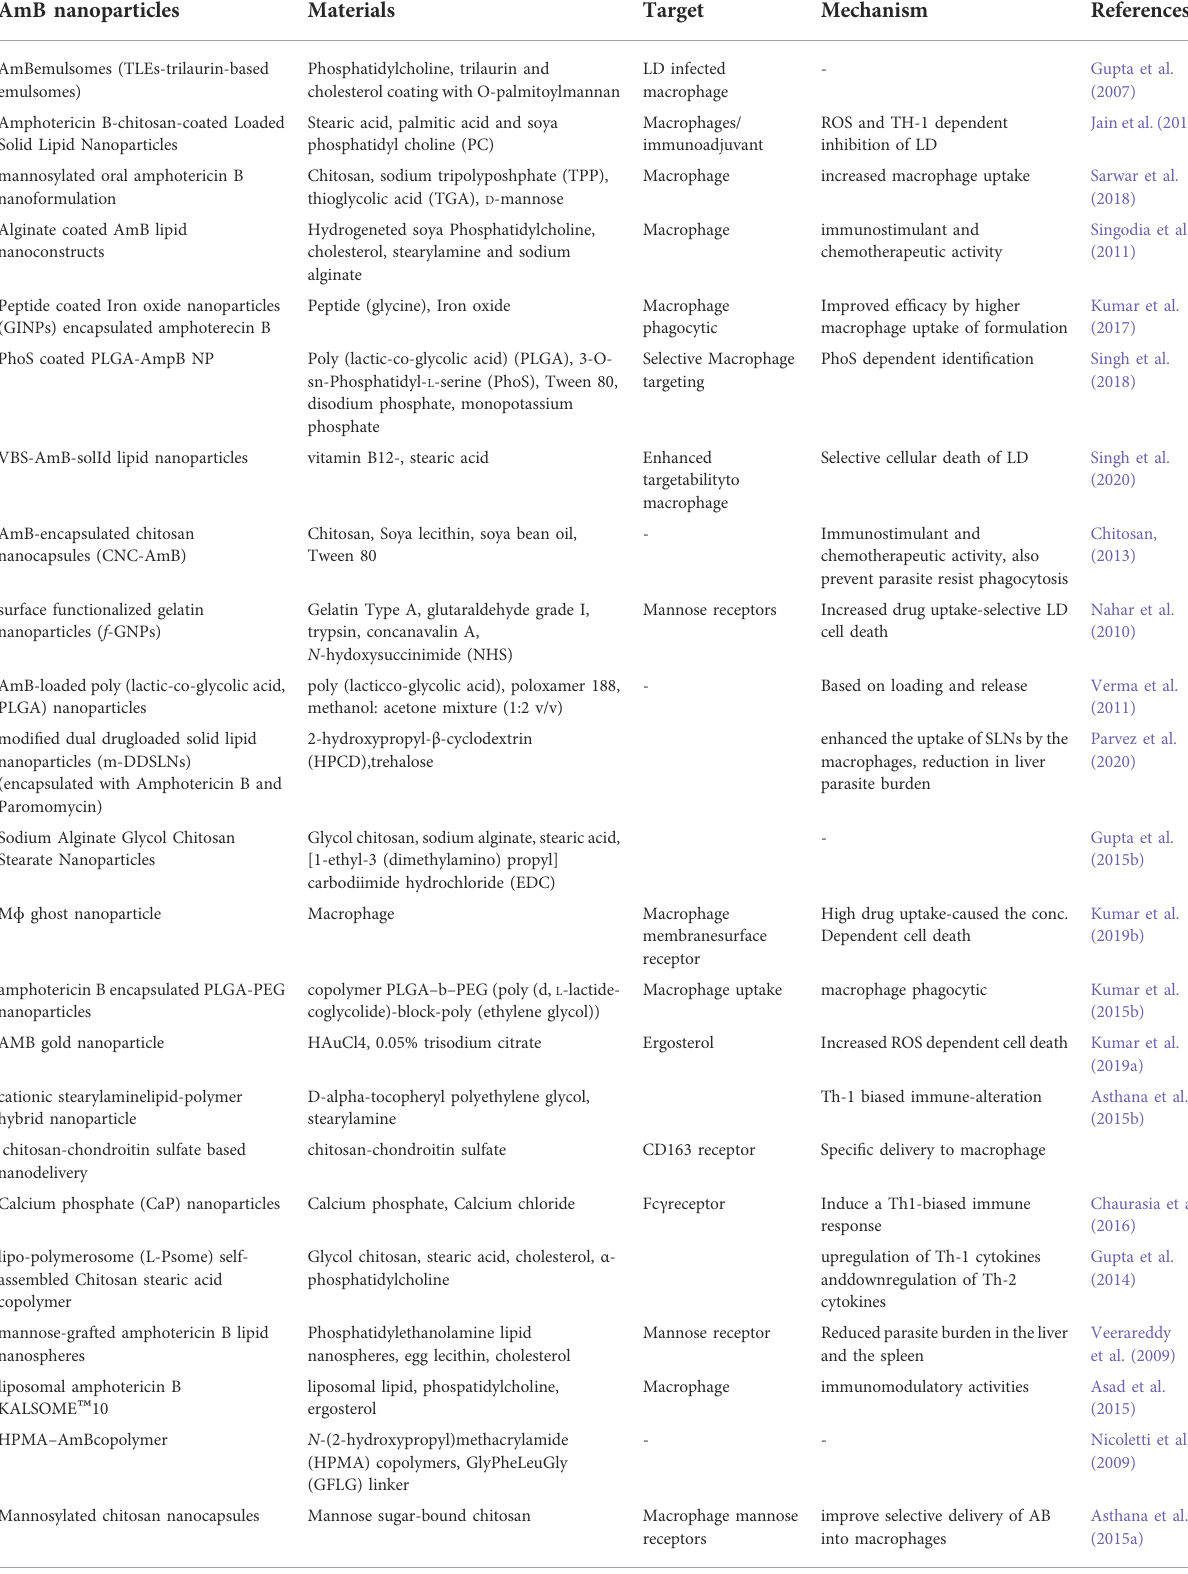
TABLE 3 Nanoparticle based AmB delivery by different approaches for VL are listed with their most probable